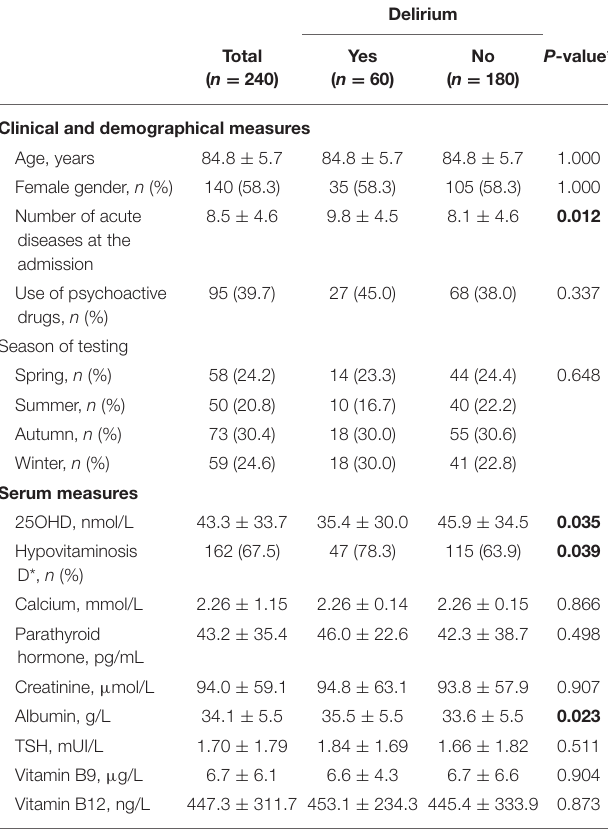
TABLE 1 | Participants’ characteristics and comparisons between cases with delirium ( n = 60) and age- and gender-matched controls without delirium ( n =